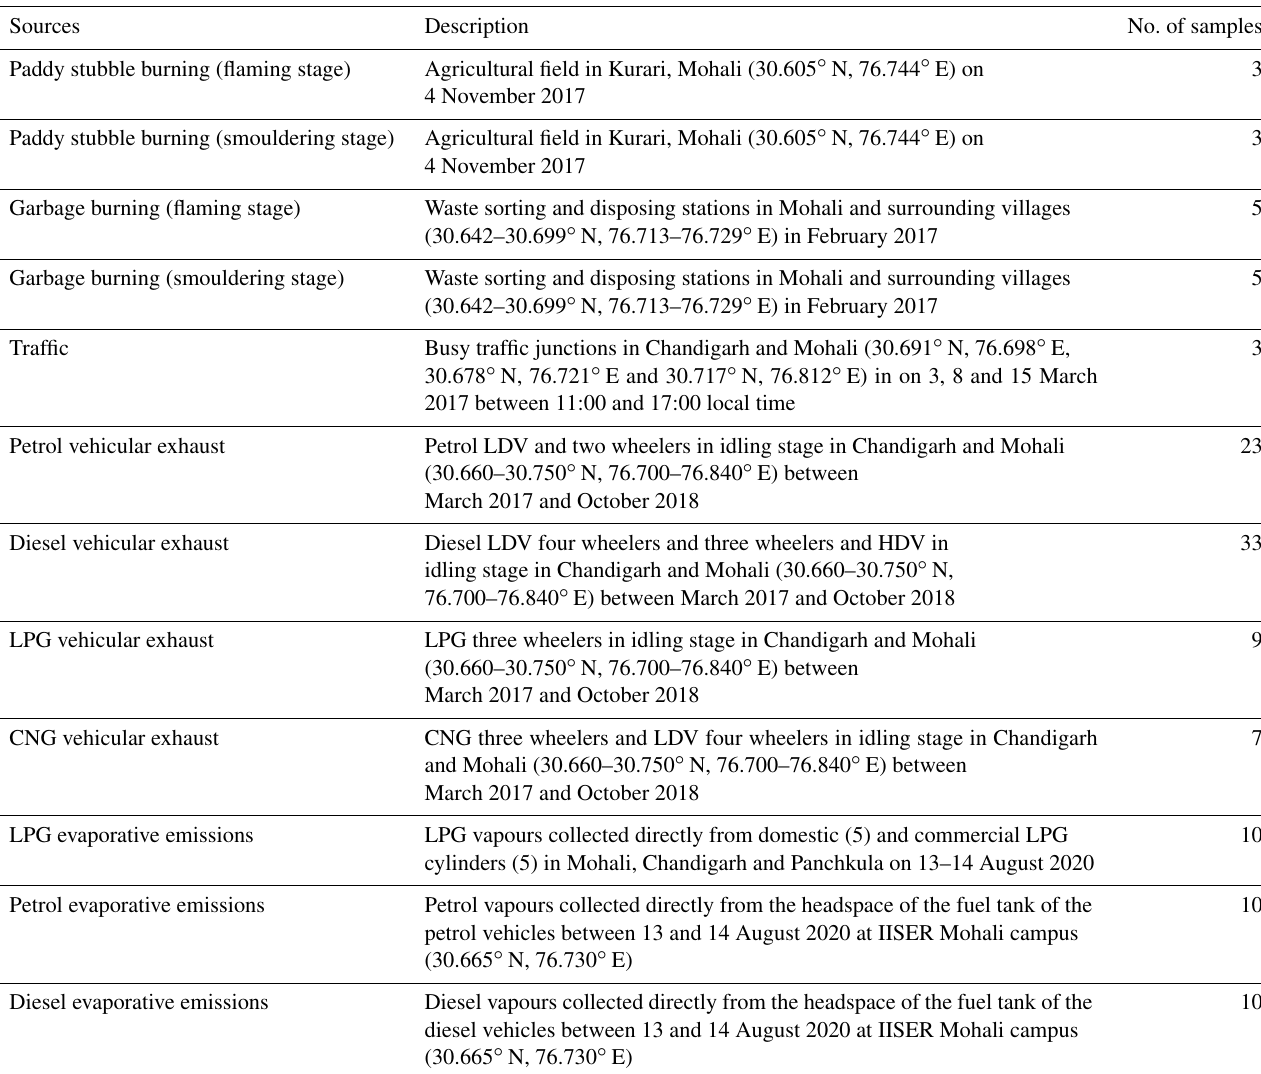
Table 1. Number of samples investigated per source for the measurements of non-methane hydrocarbons (NMHCs) source profiles. Note: liquefied petroleum gas – LPG; compressed natural gas – CNG; light-duty vehicle – LDV; heavy-duty vehicle –